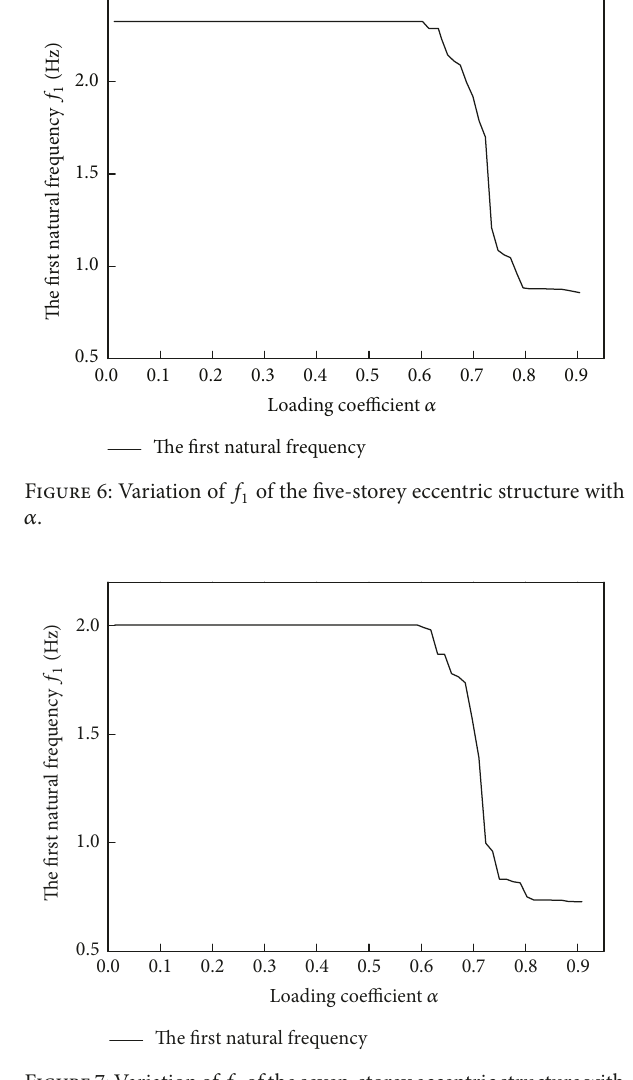
Figure7:Variationof 𝑓 1 oftheseven-storeyeccentricstructurewith 𝛼